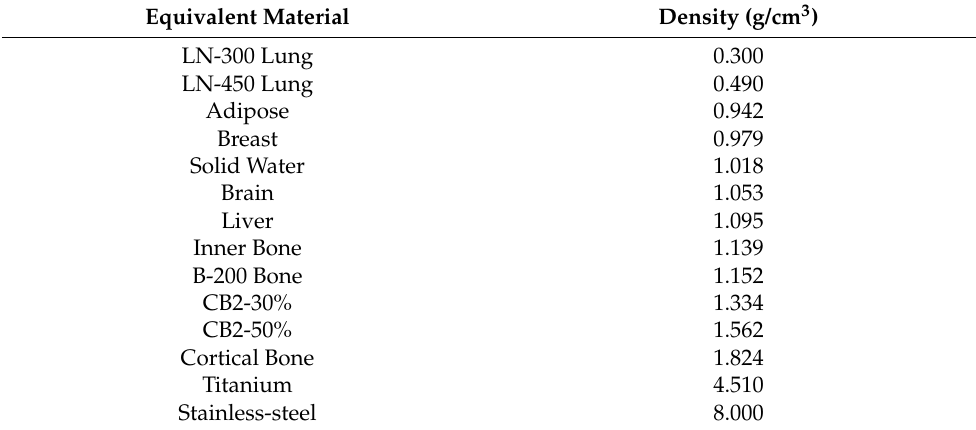
Table 1. A list of the equivalent materials of the inserts used in the Cheese phantom, with the correspondent nominal mass